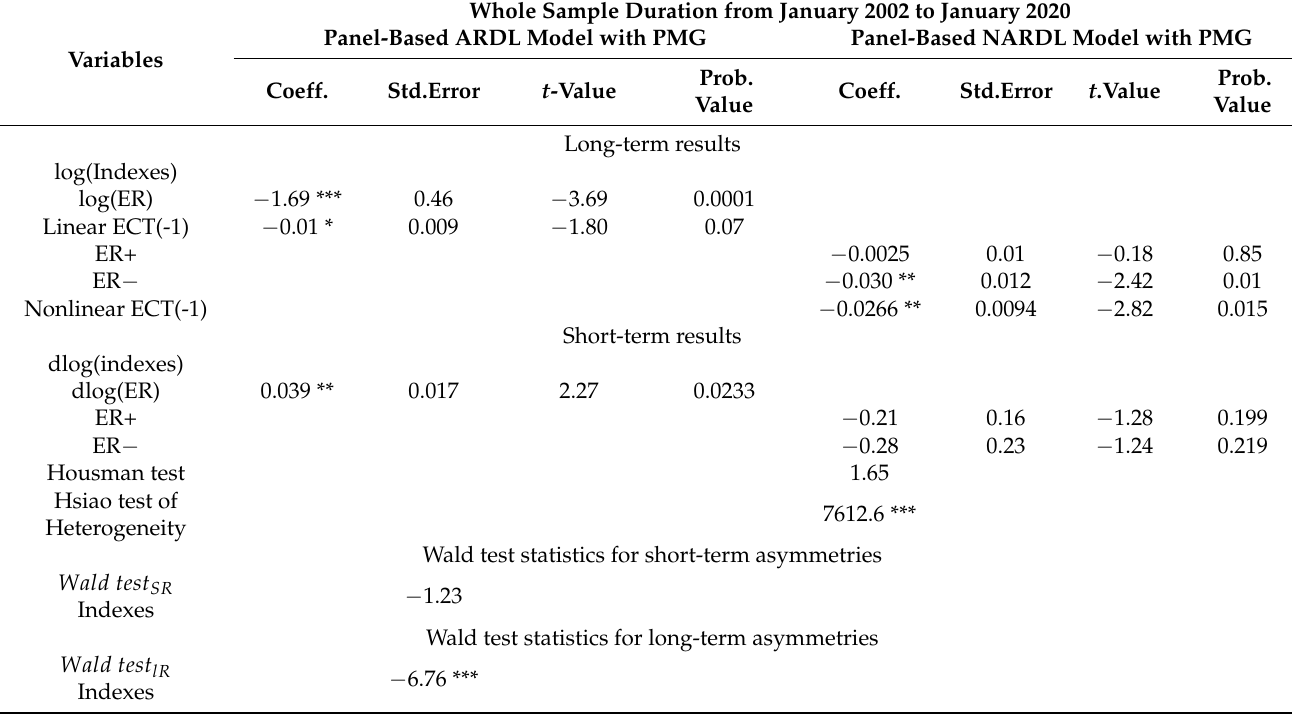
Table 8. Heterogeneous linear and nonlinear panel ARDL modeling approach with